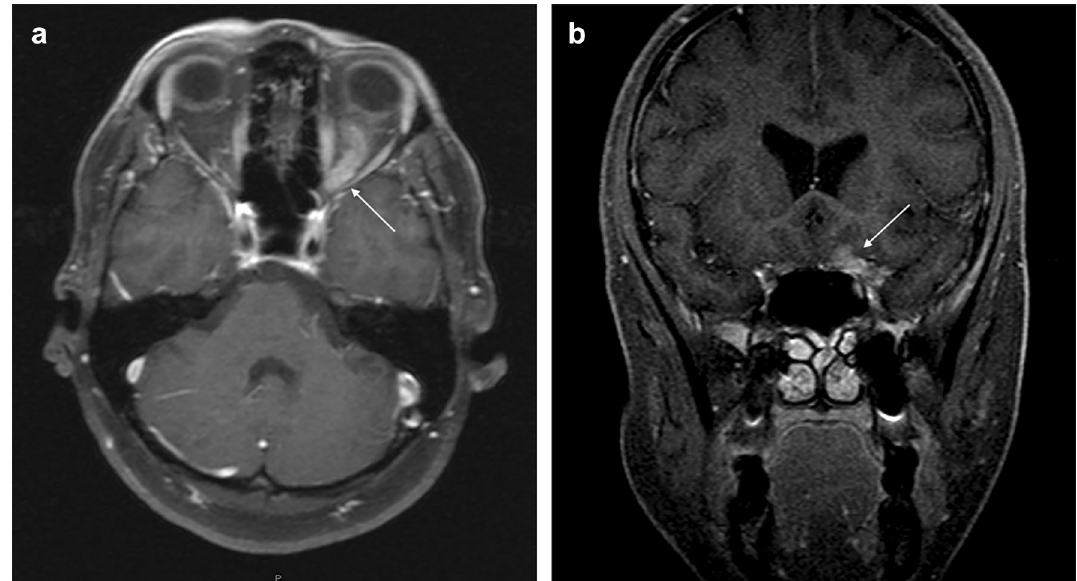
Figure 1. Sarcoidosis engaging optic nerves. ( a ) Post-contrast T1-weighted axial image shows diffuse enhancement and thickening of the left intra orbital optic nerve sheath in a 48-year-old female presenting with progressive vision loss first in left eye concerning for optic glioma. Upon biopsy a diagnosis of definite optic sarcoidosis was made. A few months later, she presented with progressive vision loss in the right eye. Receiving immunotherapy, the vision has been stable for 13 years. ( b ) Cor T1 fs Gd Shows intracranial extension of contrast enhancement around the left optic nerve.